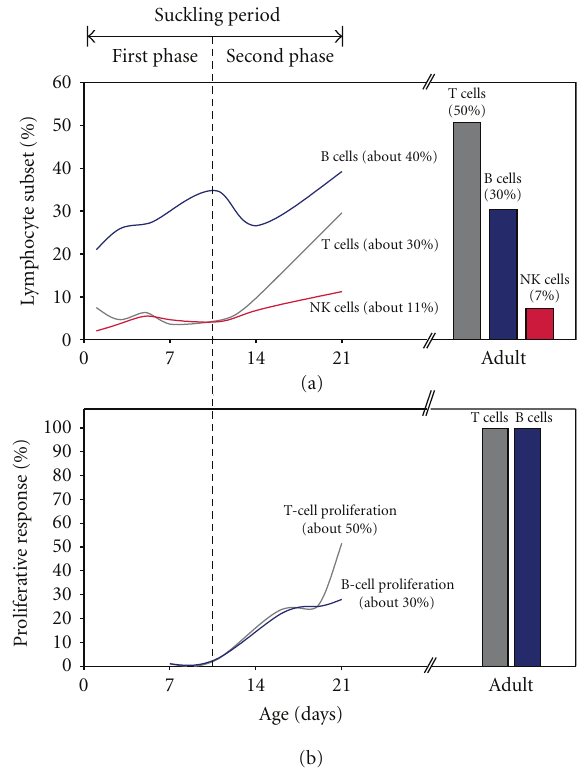
Figure 1: Developmental pattern of the systemic immune system in rats from suckling to adult age. Spleens of Lewis rats were obtained at several time points during suckling and, after mechanical spleen disruption, splenocytes were isolated by density gradient. Cells were stained by fluorochrome-conjugated monoclonal antibodies directed against several lymphocyte surface molecules (CD45RA for B cells, TCR αβ for T cells and NKR-P1A for NK cells). The percentage of each subset was established by flow cytom- etry analysis. Other splenocytes were incubated in presence of Concanavalin A or pokeweed mitogen over 72h and proliferating cells were identified by means of a cell proliferation assay [24]. (a) Main spleen lymphocyte subsets during suckling in Lewis rats (expressed as a percentage of total spleen lymphocytes). (b) Proliferative response of neonatal spleen cells with concanavalin A (T-cell proliferation) and pokeweed mitogen (B-cell proliferation) in comparison with adult Lewis rats (which is considered as 100%). Results are estimated from data obtained from 1, 3, 5, 7, 11, 14, and 21-day-old rats (modified from